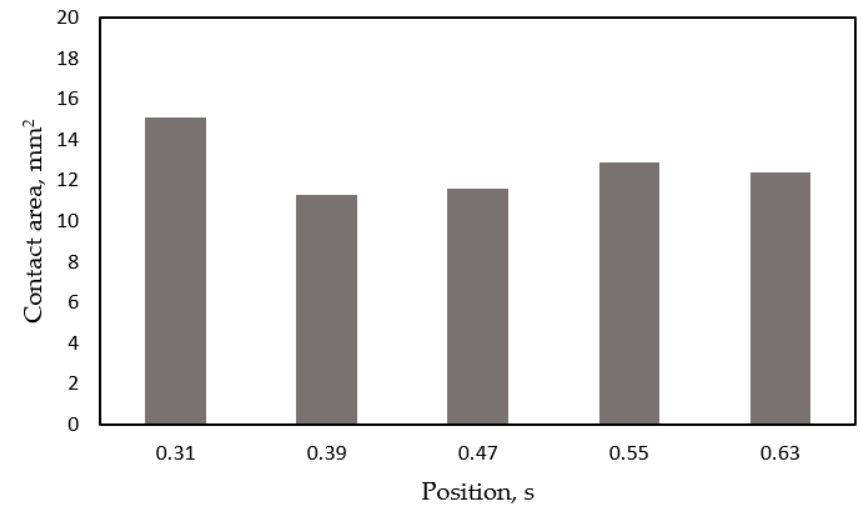
Figure 11. The images of rubber-wheel real contact area for some position along track path.